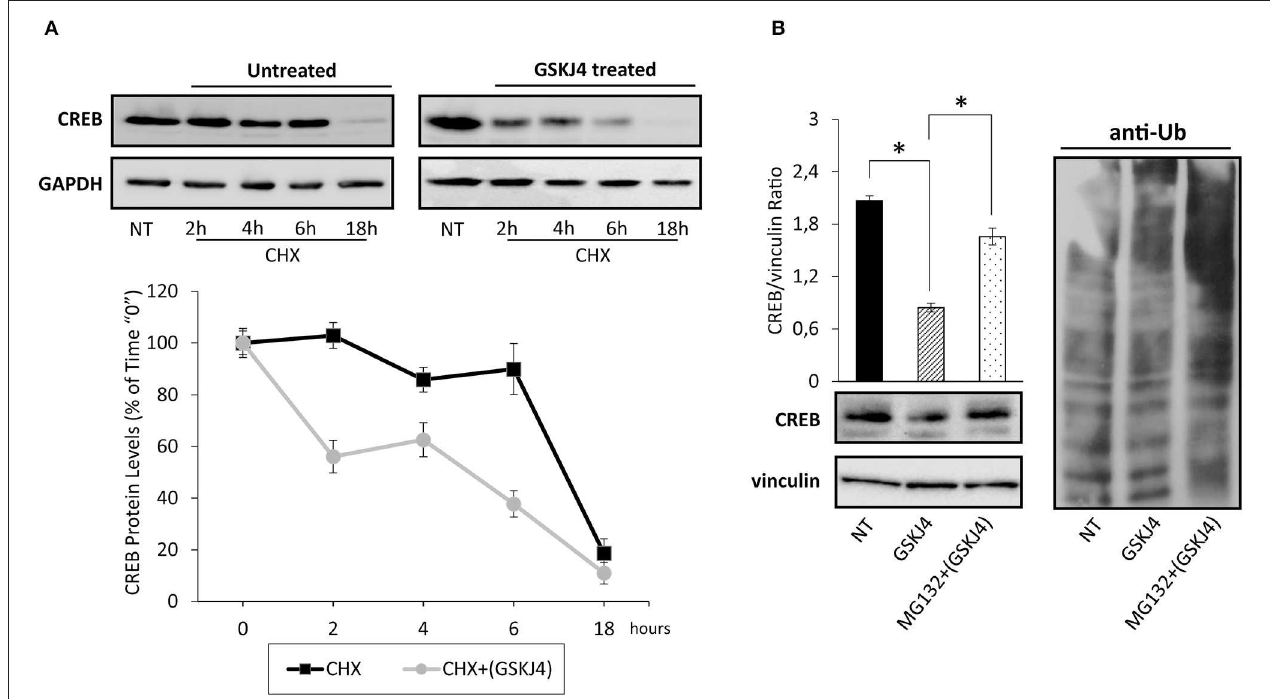
FIGURE 3 | Assessment of cAMP response element-binding (CREB) stability and ubiquitin/proteasome involvement in GSKJ4-mediated CREB downregulation in U-937 cells. (A) Cells were treated for up 18h with or without (NT) 10 µ M GSKJ4 and grown in the presence of 20 µ g/ml of protein synthesis inhibitor cycloheximide (CHX). Thereafter, CREB protein levels were determined by Western blotting (upper part) after 2, 4, 6, and 18h of treatment. For each time point, the relative CREB/vinculin Ratio of three unrelated blot images were quantified by ImageJ software and reported in graph as average and SD measure (bottom part). (B) Proteasome inhibitor MG132 at 10 µ M was administered, or not (NT), for 18h to U-937 cells kept in the presence of 10 µ M GSKJ4. CREB protein levels and the ubiquitin pattern were evaluated through Western blotting analysis in response to the above stimuli. Densitometric analyses of CREB/vinculin Ratio of three independent experiments were shown in chart and represented as average and SD values. * P < 0.05 by ANOVA and unpaired t